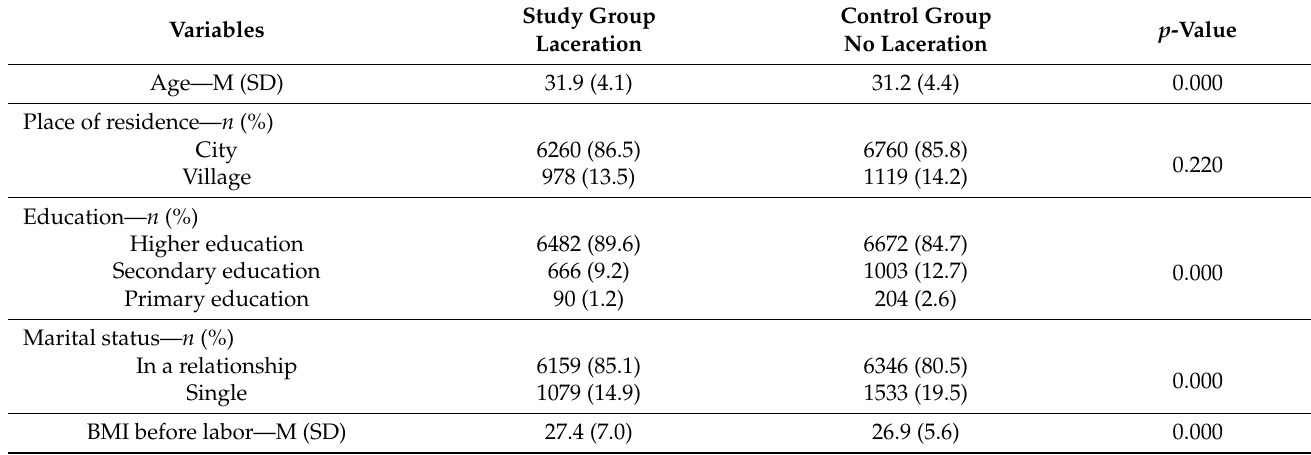
Table 1. Analysis of the dependencies between the occurrence of perineal laceration and maternal